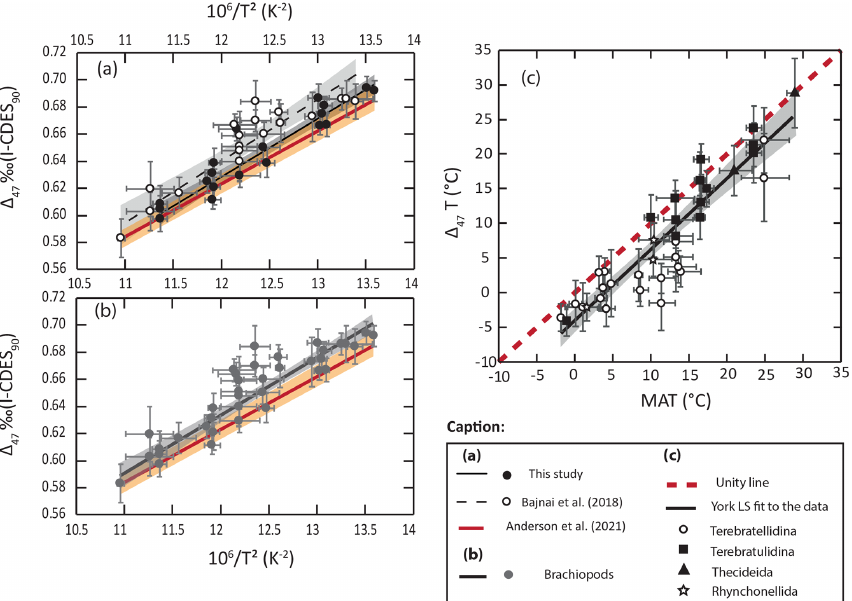
Figure 5. Comparison of (cid:49) 47 values from modern brachiopods with the state-of-the-art (cid:49) 47 calibration of Anderson et al. (2021). Envelope and error bars are at 2 σ . (a) Comparison of York least-squares regressions (York et al., 2004) derived from two modern-brachiopod datasets (Bajnai et al., 2018; this study) with the equation of Anderson et al. (2021). (b) Comparison of York least-squares regression derived from the combined modern-brachiopod dataset with the equation of Anderson et al. (2021). (c) Comparison of modern-brachiopod (cid:49) 47 temperatures calculated using the equation of Anderson et al. (2021) with seawater